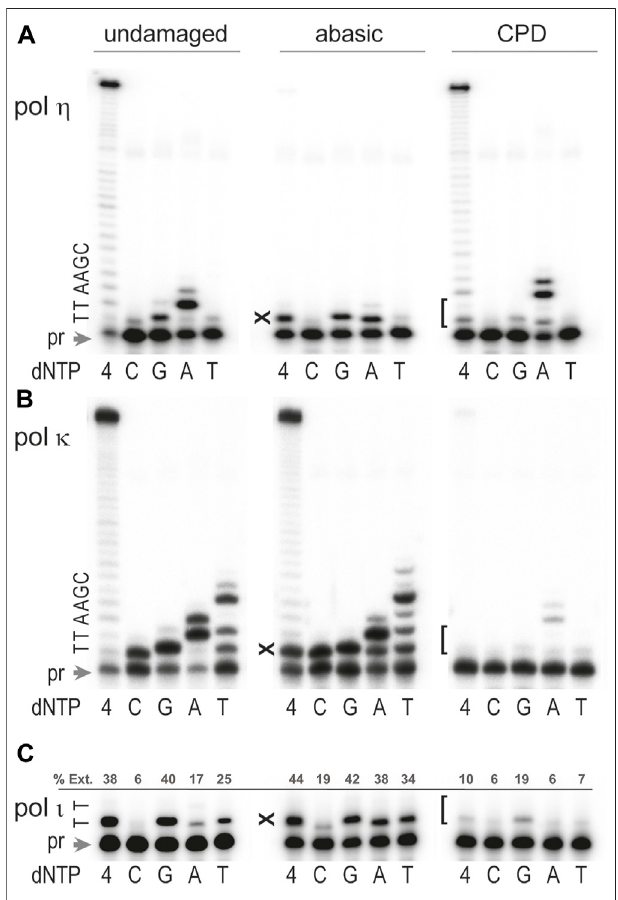
FIGURE 5 | Bypass of abasic and CPD site by Thermomyces lanuginosus polymerases. The ability to bypass abasic site and CPD by (A) pol η , (B) pol κ ,and (C) pol ι wasassayedbymeasuringextensionof 32 Plabeled primer 5 ′ -CGATGGTACGGACGTGCTT-3 ′ hybridized to the undamaged or damaged DNA template. 5 ′ - TCGATACTGGTACTAATGATTAACGAA- TN -AAGCACGTCCGTACCATCG- 3 ’ . The underlined bold TN sequence stands for the undamaged TT, TT-CPD, or TX, whereX isanabasic site, prisunextendedprimer.Reactionscontained 100 μ M each individual nucleotide (dC, dG, dA, dT) or mixture of all four dNTPs as indicated in the Figure, and 4 mM Mn 2+ for reactions catalyzed by pol ι or Mg 2+ for reactions with pol η and pol κ . Primer extension reactions were carried out at 37 ° C for 10 min. Concentrations of enzymes were 0.17 pM for pol η , 0.32 pM for pol κ , and 0.15 pM for pol ι . The sequence of the template immediately downstream of the primer (pr) is shown on the left-hand side of each gel pair. “ X ” denotes the position of the abasic site and “ [ ” indicates position of the T-T CPD. For panel C, primer extension (%Ext.) was quanti fi ed using ImageJ software and reported as the percentage of product density relative to total density for each